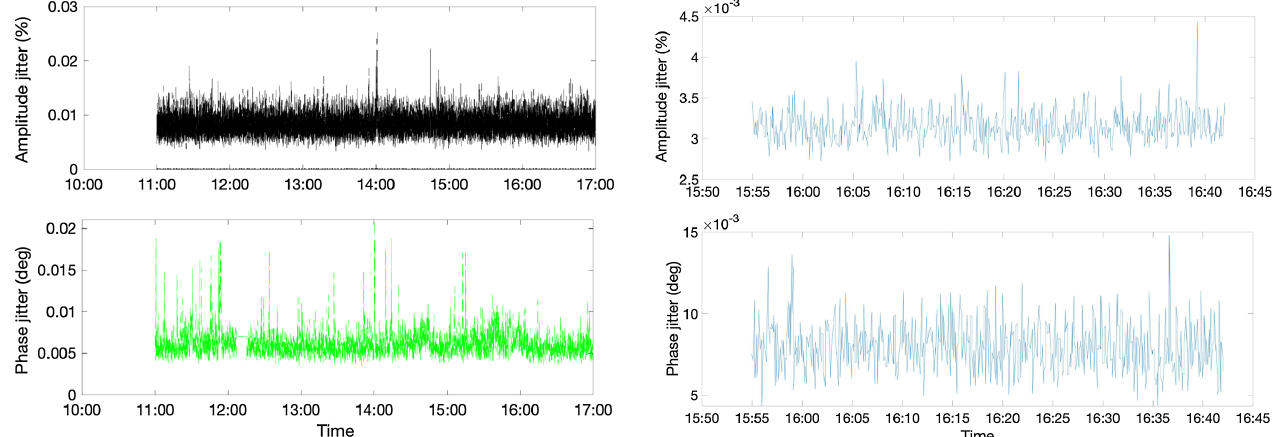
FIG. 5. Gun (left) and buncher (right) probe signal amplitude and phase jitter versus time with the feedback on.